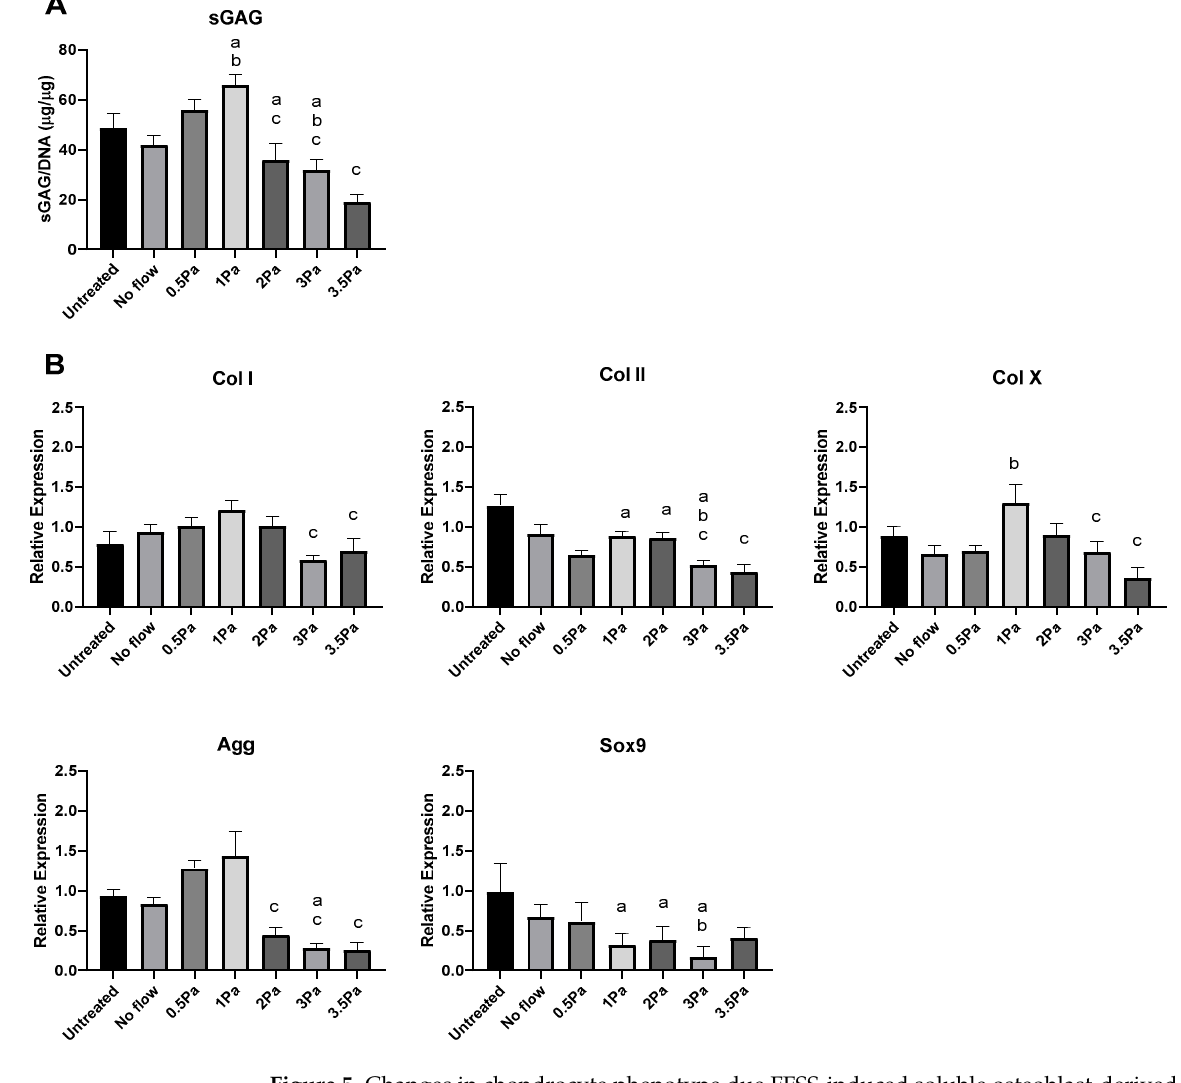
Figure 5. Changes in chondrocyte phenotype due FFSS-induced soluble osteoblast-derived factors. ( A ) sGAG levels in ACs following exposure to FFSS-induced soluble osteoblast-derived factors, normalized to DNA content. ( B ) AC gene expression of collagen I, II, and X, SOX9, and aggrecan at 3 day following exposure to conditioned media. Expression data were calculated using the 2 −ΔΔ Ct method relative to averaged day 1 samples and normalized using 18S as endogenous control. All regimes were at 1 Hz for 1 h. Statistical differences are shown where (a) represents significant difference compared with untreated control (b) represents significant difference compared with no-flow control and (c) represents significant difference compared with 1 Pa, to the level of p < 0.05.